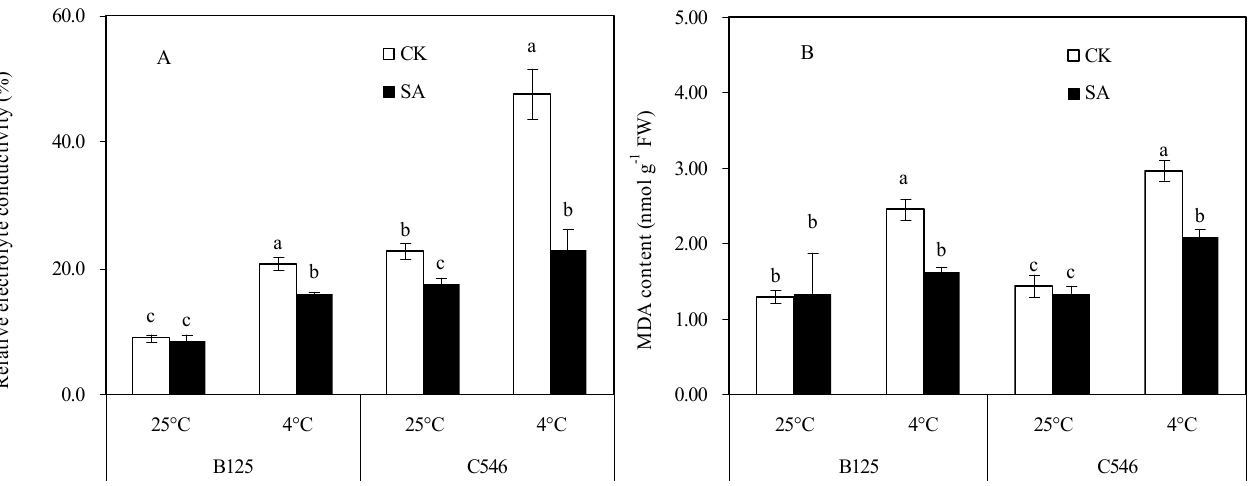
Figure 1. Effects of SA treatment on relative electrolyte conductivity ( A ) and malondialdehyde content (MDA) ( B ) in C546 and B125 maize seedlings. The plants were treated at 4 °C for 2 days. The different letters indicate significant differences between different SA concentrations under two temperatures within the same inbred line at p < 0.05.